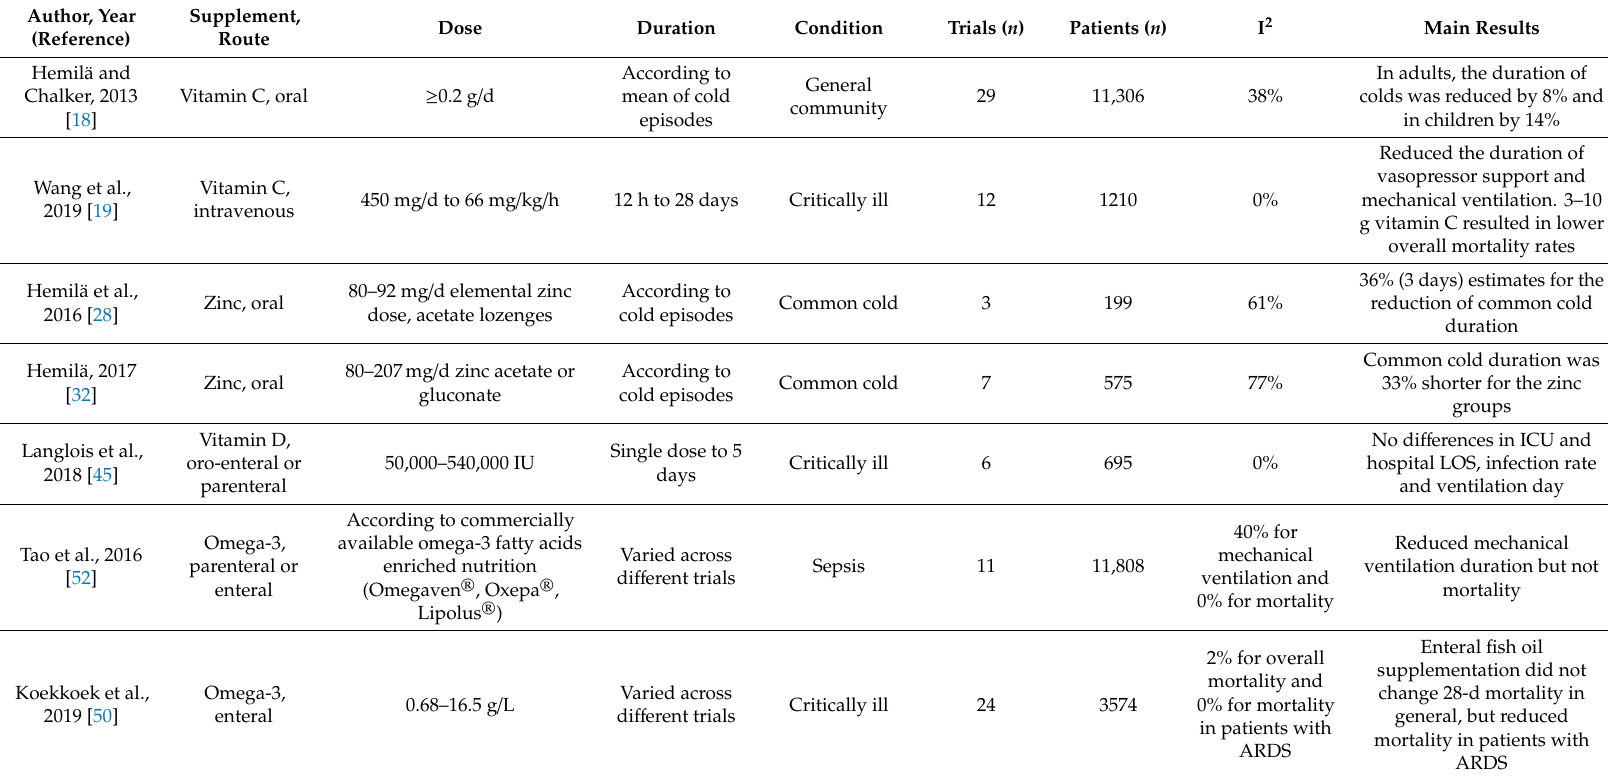
Table 2. Summary of main findings of the meta-analyses appraised in the current review. Collectively, those studies addressed pharmaconutrition strategies through randomized clinical trials with medical outcomes that show potential in the management of